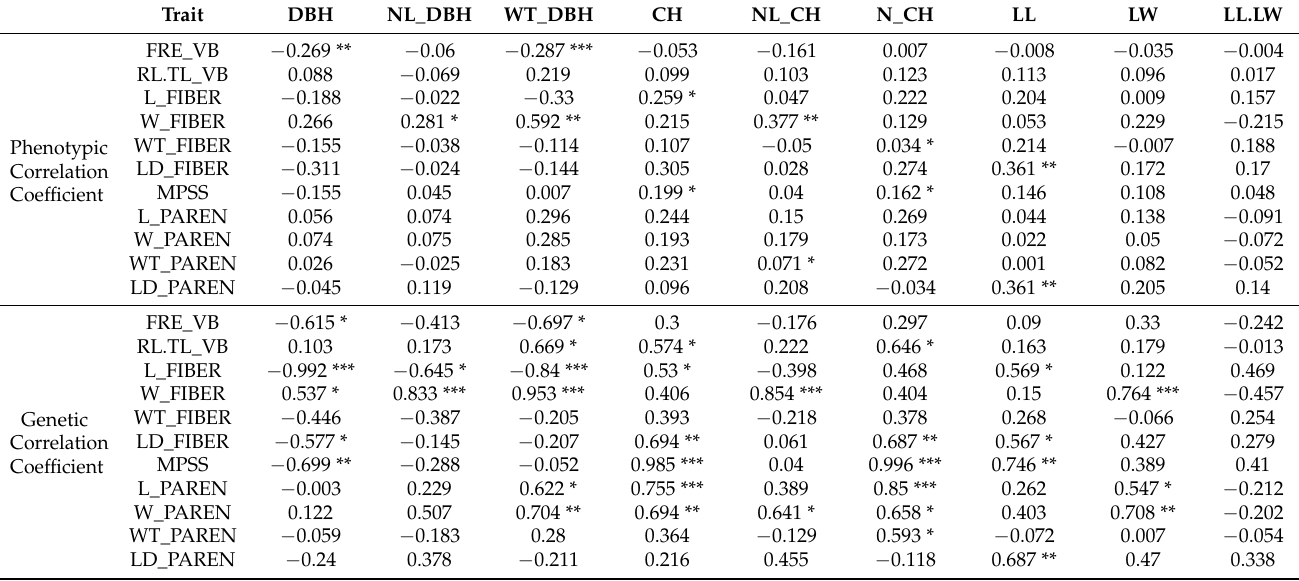
(Table 2). That indicated that there was not much correlation between phenotypic traits and cell structure properties on the whole. There were four groups of traits to obtain medium and high correlation that showed a close correlation. Table 2. Correlation analysis between phenotypic traits and cell structure properties in Moso bamboo ( Phyllostachys edulis